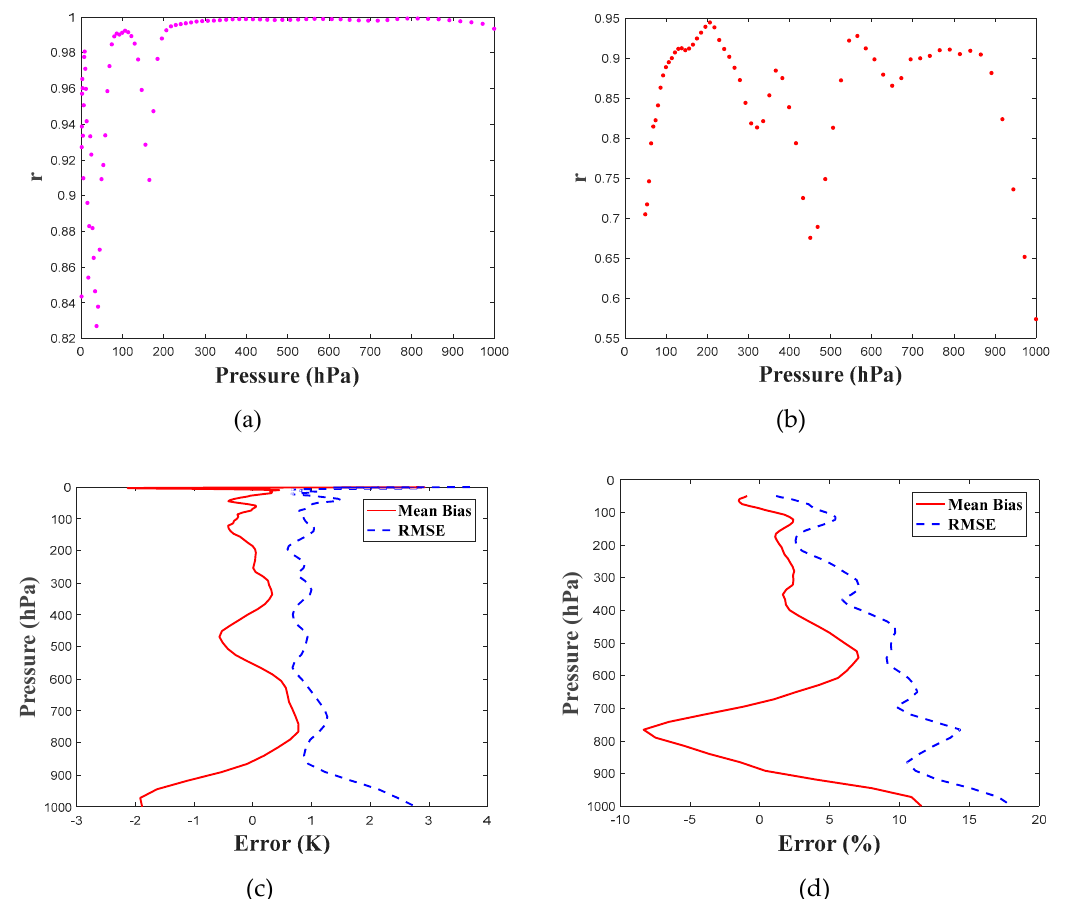
Figure 12. ( a ) The correlation coefficient between the temperature profiles retrieved from HIRAS and the temperature products from AIRS, ( b ) the correlation coefficient between the relative humidity profiles retrieved from HIRAS and the relative humidity products from AIRS, ( c , d ) the bias and RMSE for temperature and humidity, respectively. AIRS products are denoted as the standard profiles.